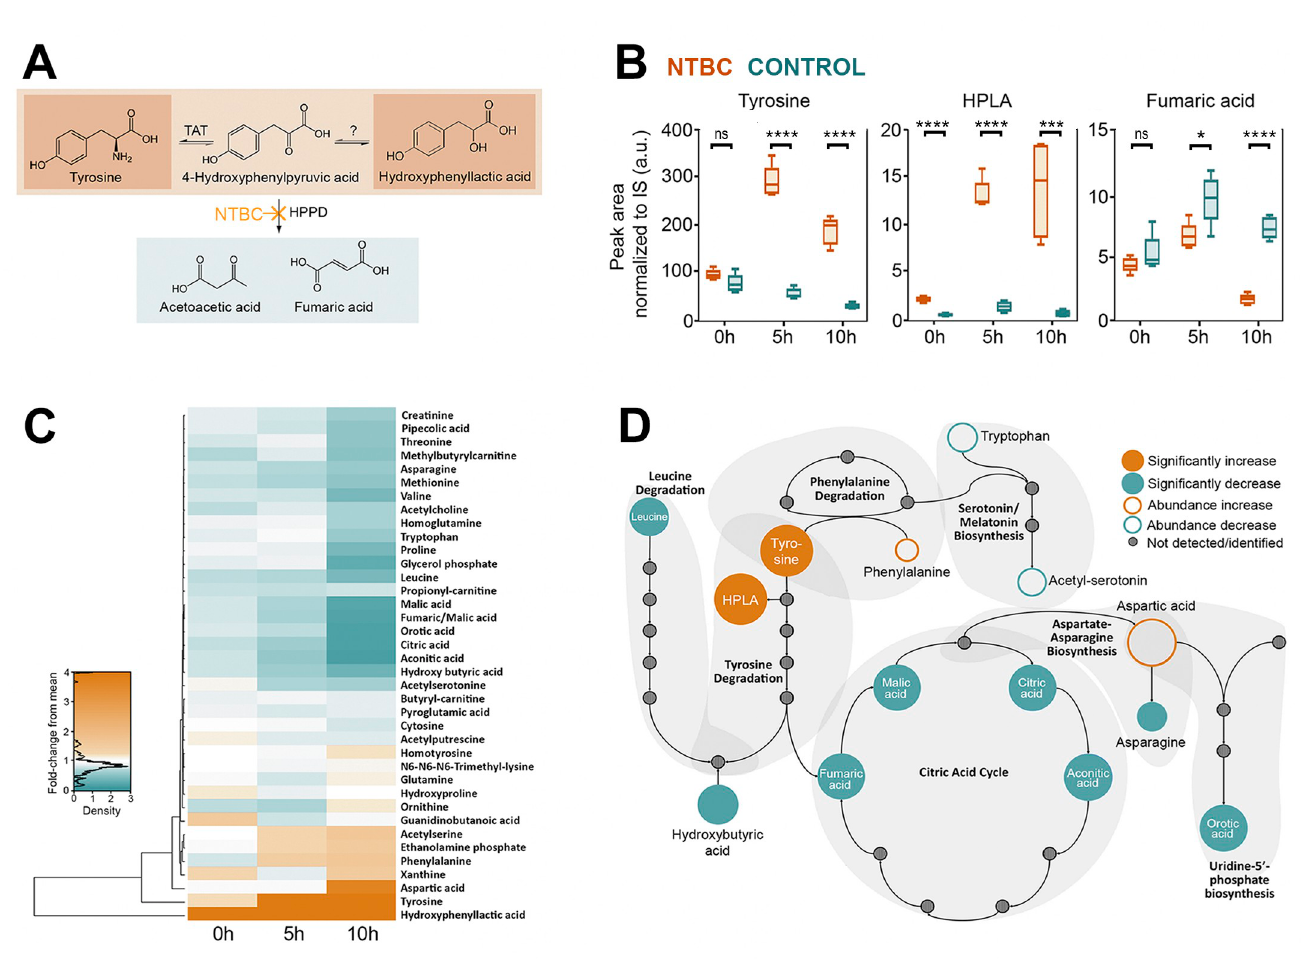
Fig 3. Metabolomic analysis of tsetse haemolymph upon NTBC treatment at different times post-bloodmeal (0, 5, and 10 hours). Five samples (in each group and for each time point) collected from two independent experiments were processed for and analysed by mass spectrometry. (A) Schematic representation of the tyrosine catabolic pathway highlights the main metabolites accumulated and the decreased production of final products. (B) Peak area normalised to internal standards of differentially regulated metabolites in the tyrosine catabolism pathway. ns = P > 0.05, � = P � 0.05, �� = P � 0.01, ��� = P � 0.001, ���� = P � 0.0001. (C) A heat map graphically presents the metabolites identified. (D) Schematic representation of the metabolic pathways indicates metabolites that were differentially regulated in NTBC-treated flies. The underlying data for this figure can be found in S1 Data. HPLA, 4-hydroxyphenyl lactic acid; HPPD, 4-hydroxyphenylpyruvate dioxygenase; NTBC, nitisinone; TAT, tyrosine aminotransferase.